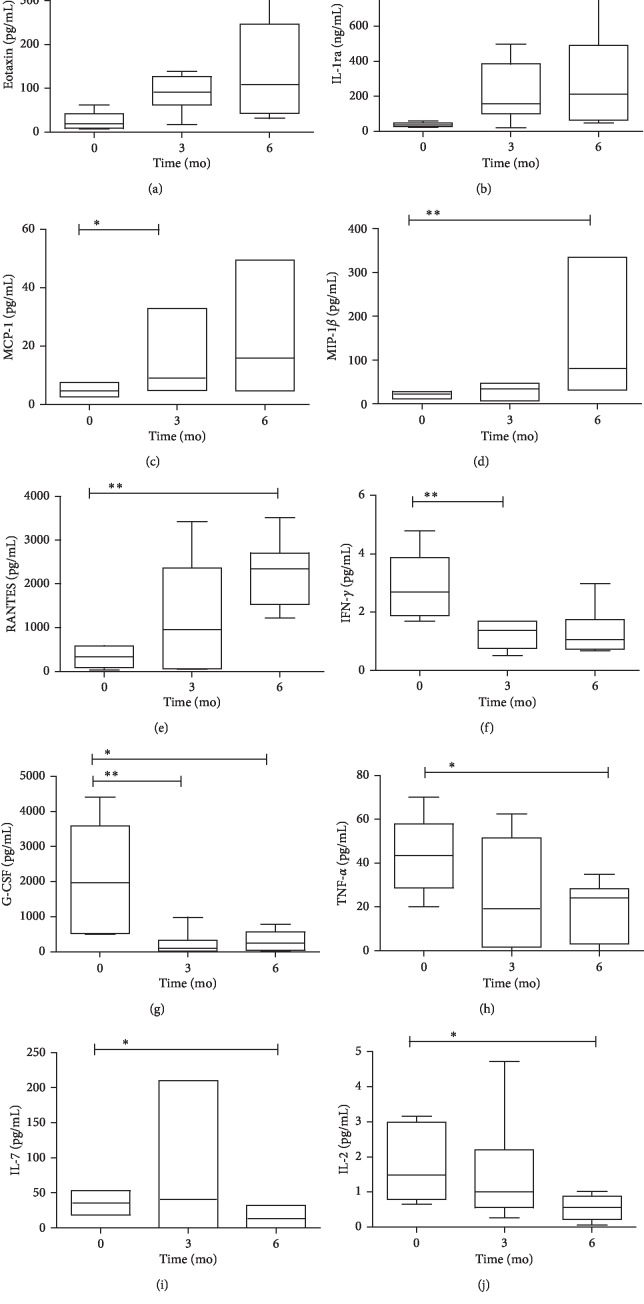
Alternations of cytokine levels in SAA patients after immunosuppressive therapy (IST). In six SAA patients who responded to rabbit ATG + cyclosporine, BMP cytokine concentrations were measured before and three and six months after IST. Differences in cytokine levels before IST versus three months and six months after IST were assessed using an independent t-test or a Mann–Whitney U test depending on the data distribution ∗∗p < 0.01, ∗p < 0.05.